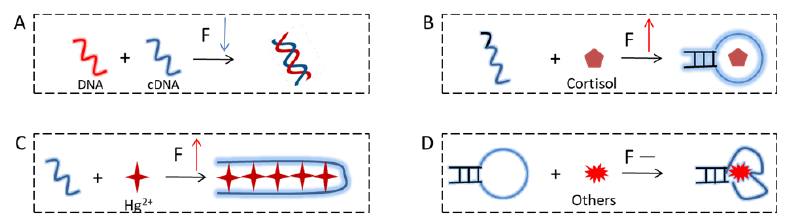
Figure 6. Schemes showing changes in DNA intrinsic fluorescence upon ( A ) DNA hybridization, and target binding to the ( B ) cortisol aptamer, ( C ) T30, and ( D ) the adenosine and caffeine aptamers that did not show a fluorescence change.